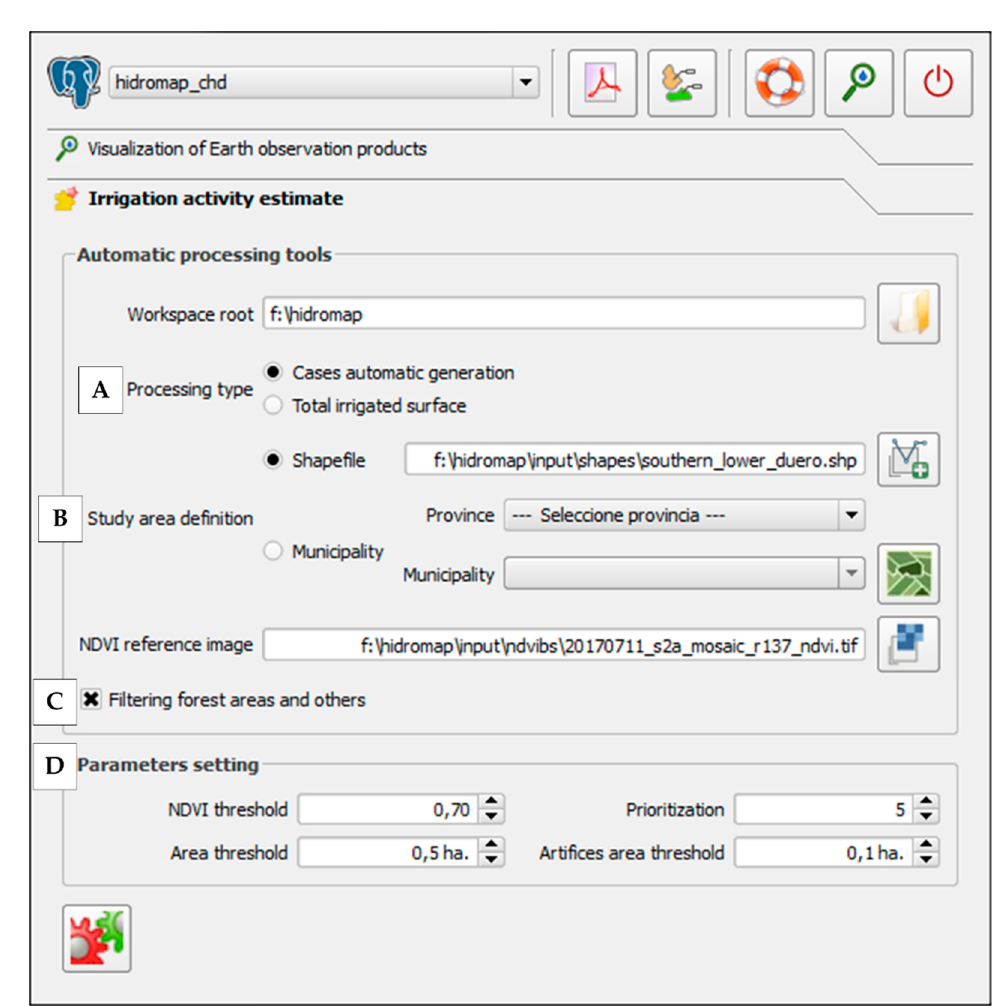
Figure 3. HidroMap desktop-GIS module interface. ( A ) Processing type; ( B ) Study area definition; ( C ) Filtering forest areas and others; and ( D ) Parameters setting.